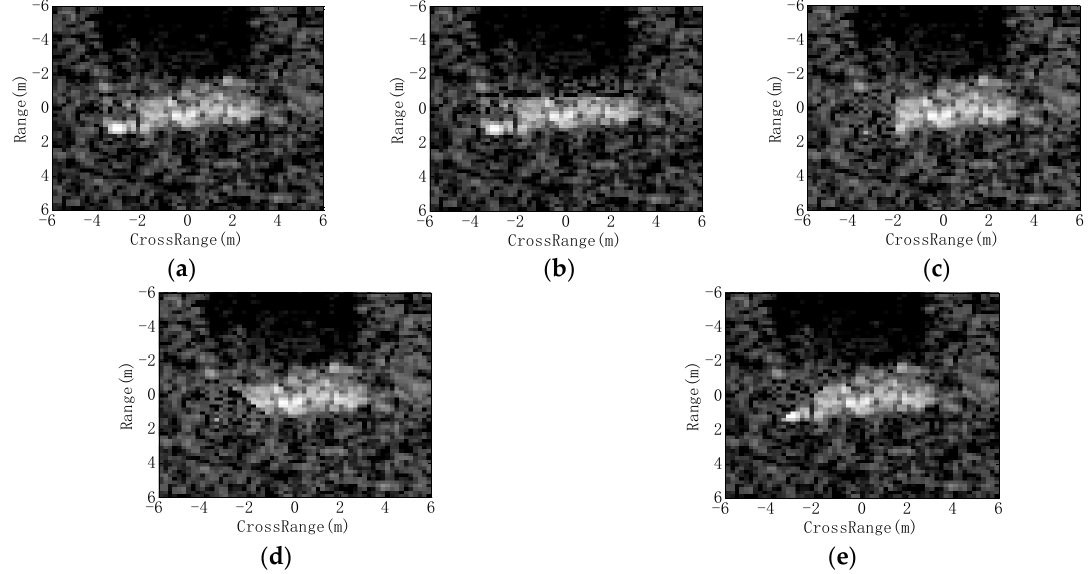
Figure 13. Occluded images at the occlusion level of 20% from different directions being: ( a ) original image; ( b ) direction 1; ( c ) direction 2; ( d ) direction 3; ( e ) direction 4.